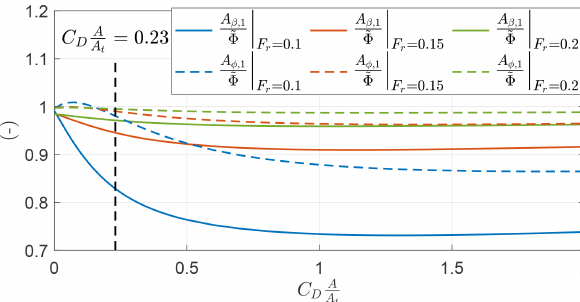
Figure 23. Optimal values of A β, 1 and A φ, 1 , normalized with the analytical expression of the opening angle ˜ (cid:56) , as a function of C D A for different Froude